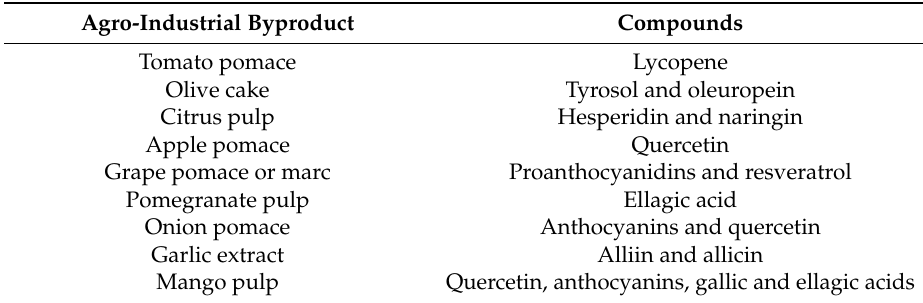
Table 2. Agro-industrial byproducts and their major bioactive compounds that could be potentially used as skin photoprotectants